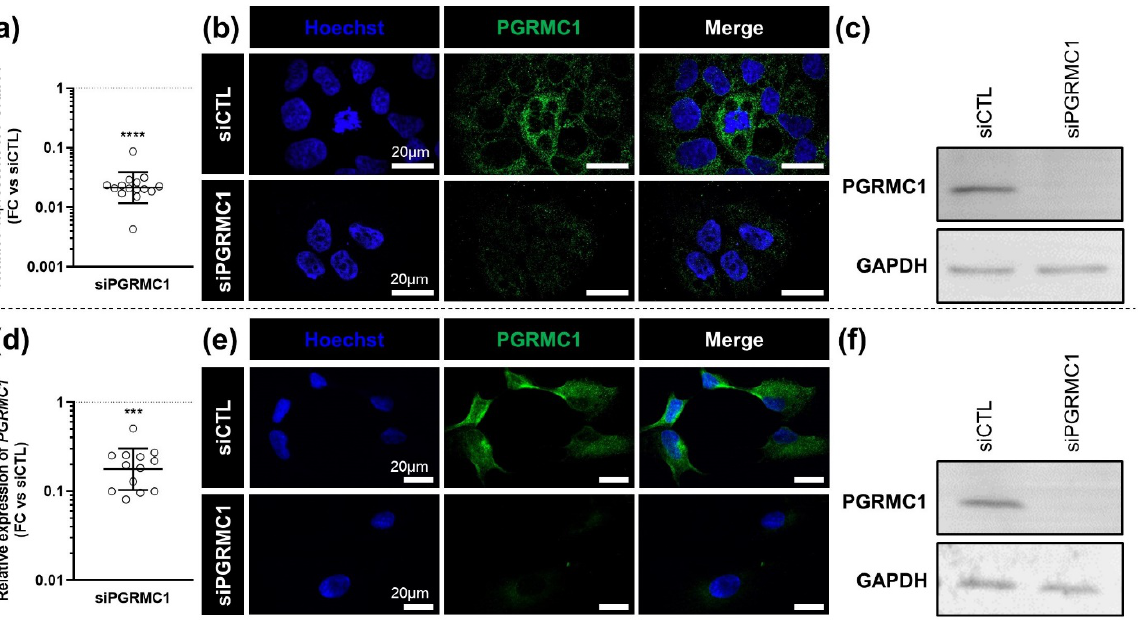
Figure 3. siRNA-PGRMC1 decreases expression of PGRMC1. Relative expression, immunolocalization and immunoblotting of PGRMC1 in HEC-1A ( a – c ) and T-HESC ( d – f ) cell lines treated with 10 nM of siRNA-PGRMC1 s21310 (siPGRMC1) or control siRNA-CTL (siCTL) during 80 h. ( a , d ) Relative expression of PGRMC1 was measured by RT-qPCR, normalized, compared to corresponding siCTL values and is presented as individual fold changes (FC) in log scale and as geometric means with geometric SD ( n = 13–15). Statistical test: Wilcoxon paired test, not significant (ns), *** p < 0.001, **** p < 0.0001. ( b , e ) Immunocytofluorescence of PGRMC1 protein (in green) and nuclear staining (Hoechst, in blue) ( n = 4). ( c , f ) Immunoblot of PGRMC1 (24 kDa). GAPDH (36 kDa) was used as loading control ( n = 3).